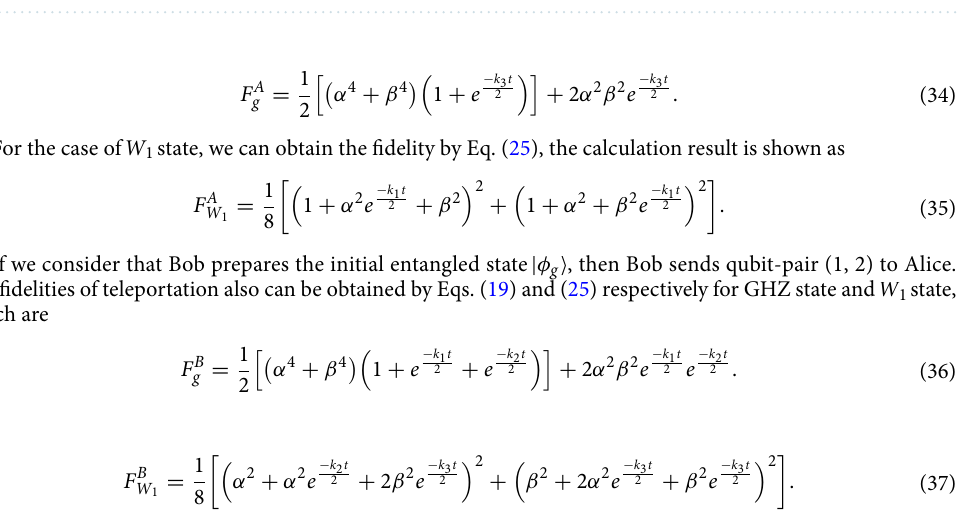
Figure 4. The comparison of fidelities of quantum teleportation between GHZ state and W 1 state with the help of WM and RM.